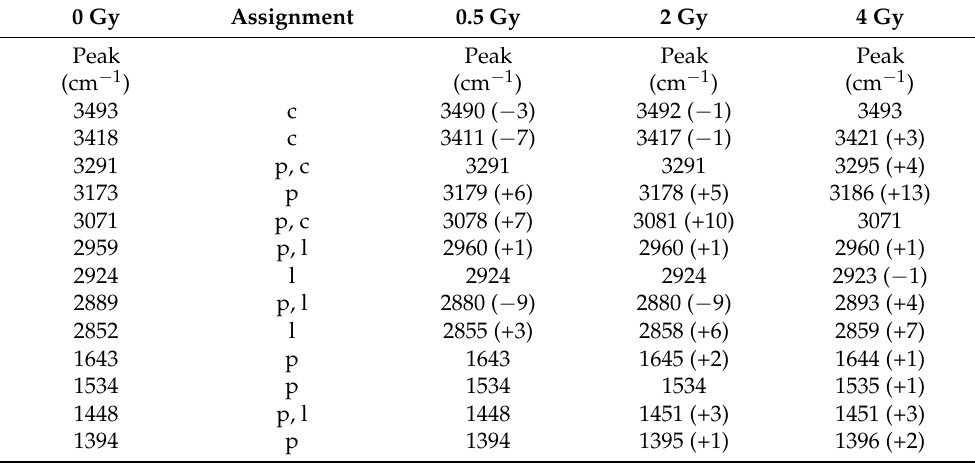
Table 3. Average FTIR peaks position for control and samples treated with different doses fixed immediately after irradiation. The shifts in respect of the non-irradiated sample, in terms of units of wavenumber are indicated in brackets (bold values stand for shifts greater than the spectral resolution of the instrument 4 cm − 1 ). Abbreviations: p = proteins, l = lipids, c =